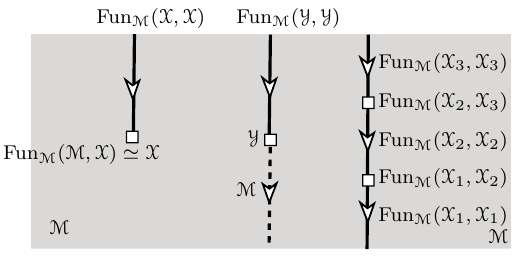
Figure 2 . This picture illustrates some 1d, 0d domain walls in an anomaly-free 2d topological order M